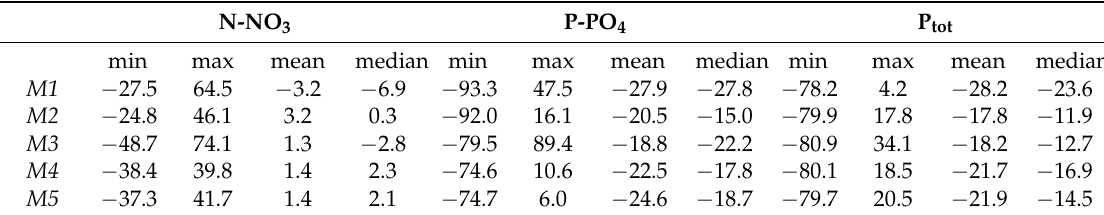
Table 4. Accuracy statistics (%) of the M1 to M5 algorithms related to the true load (M6) on an annual basis for all the substances, sites, and monitored